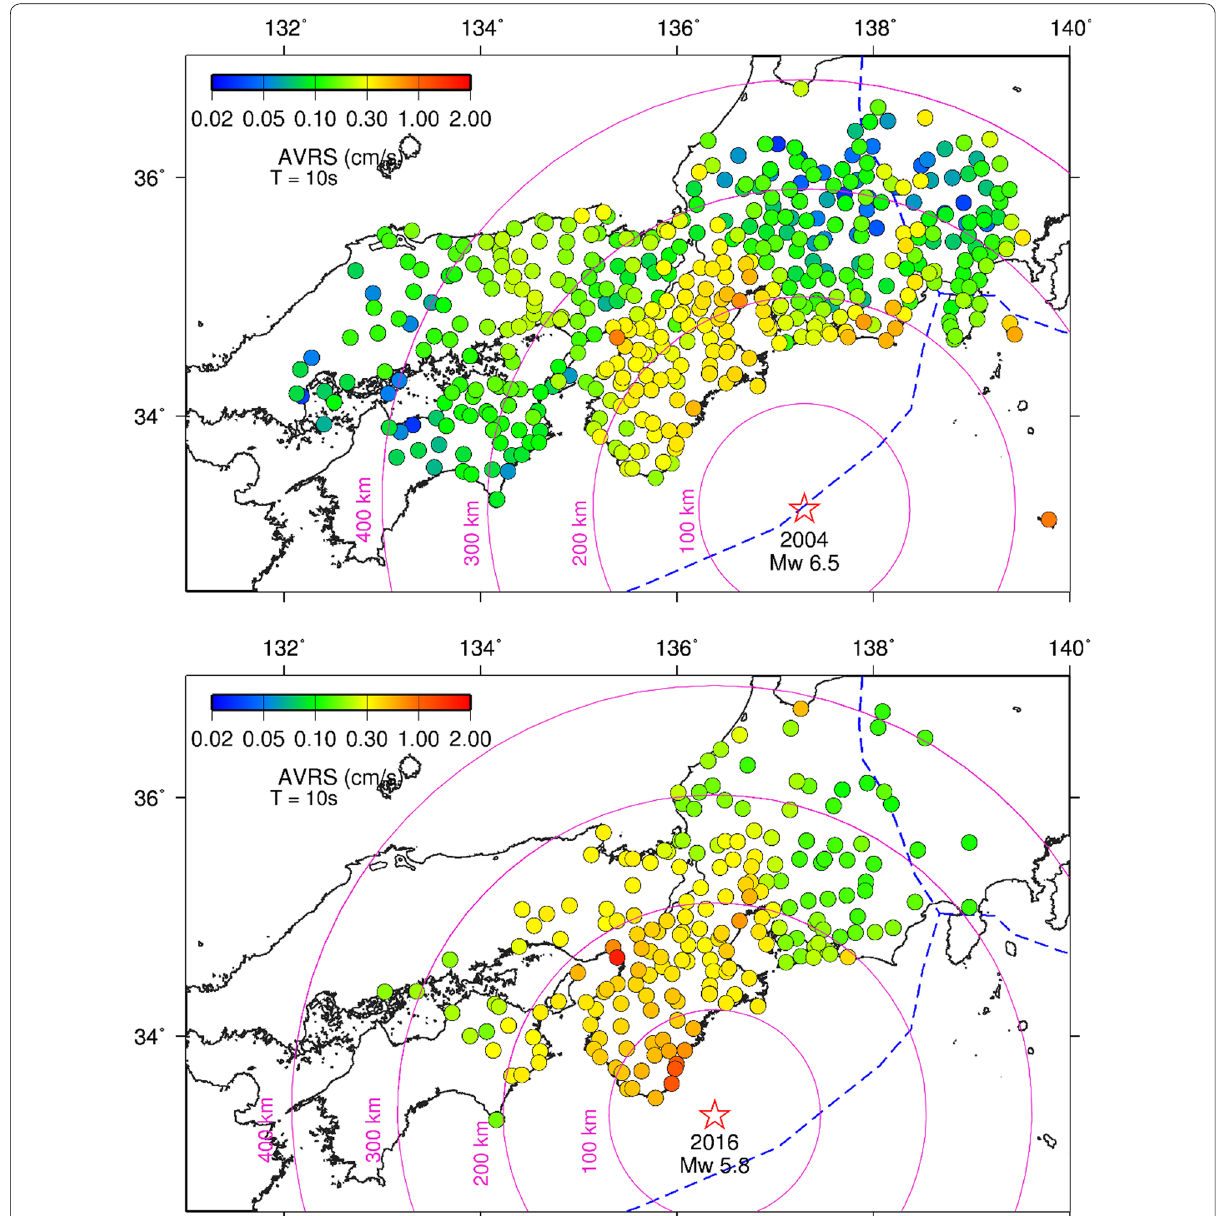
Fig. 12 Spatial distribution of AVRS at the period of 10 s for the 2004 Mw 6.5 event (upper panel) and 2016 Mw 5.8 event (lower panel). Circles are drawn for radii of 100, 200, 300, and 400 km with the epicenters as the centers of the